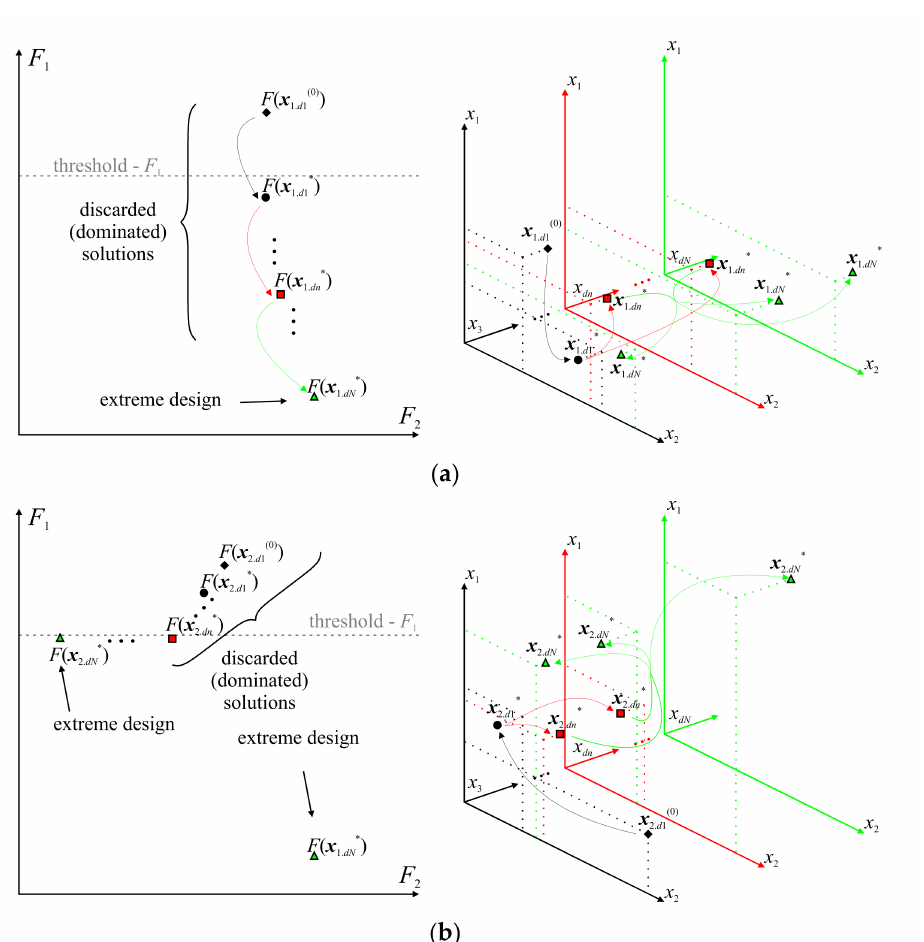
Figure 3. Generation of the extreme Pareto designs, with a conceptual illustration of the feature ( left ) and design ( right ) spaces; optimization w.r.t. ( a ) first and ( b ) second design objective. Note that the design space is represented in the form of three-dimensional projections (hence, the solutions for d 1 = 3 are shown only on the black plot, whereas the designs with d n and d N parameters are shown on two and three plots at a time). The optimal geometry obtained for the structure represented using d n − 1 dimensional design is used as a starting point for optimization of the d n dimensional